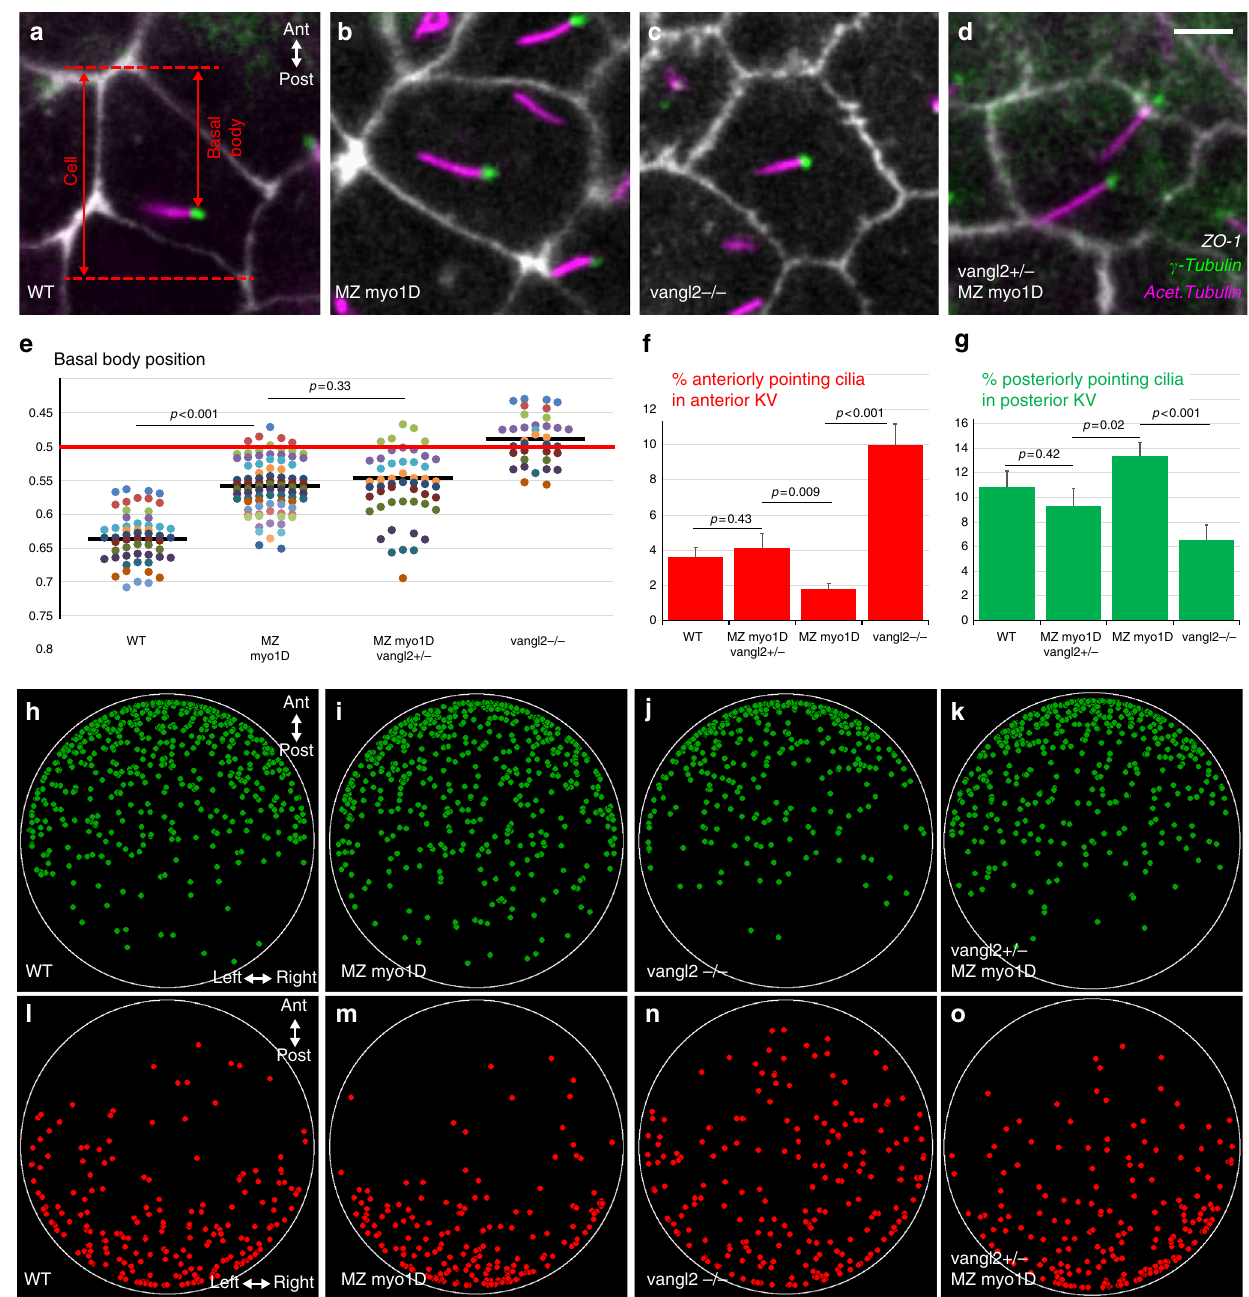
Fig. 6 myo1D interacts with vangl2 to control cilia orientation in the zebra fi sh left – right Organizer. a – e myo1D and vangl2 are required for basal body positioning. a – d High magni fi cation views of KV cells (ZO-1) with cilia (acetylated tubulin) and basal bodies ( γ -tubulin). e Dot plot representing average antero-posterior basal body position in individual embryos (see Methods). Compared to WT ( a , n = 40 embryos/744 basal bodies), basal bodies are displaced anteriorly in MZ myo1D ( b , n = 74/1521) or vangl2 ( c , n = 36/526) mutants. Basal bodies are similarly affected in MZ myo1D and MZ myo1D ; vangl2 + / − ( d , n = 37/826). f , g MZ myo1D ( n = 93 embryos/3172 cilia) and vangl2 ( n = 50/1545) mutations have opposing effects on cilia orientation. Cilia orientation in MZ myo1D ; vangl2 + / − ( n = 35/1225) is similar to WT ( n = 55/2275). h – o two-dimensional dot plots indicating the position of KV cilia pointing to the anterior (red) or posterior (green) in the KV of embryos of different genotypes. Posteriorly pointing cilia invade the posterior KV in MZ myo1D ( i ), while anterior pointing cilia invaded the anterior KV in vangl2 − / − ( n ). In MZ myo1D ; vangl2 + / − ( k , o ), cilia distribution is again more similar to WT (see Supplementary Fig. 9 for details). All data collected at eight-somites stage, anterior up in a – d , h – o . Horizontal bars in e represent mean values. Error bars in f , g indicate SEM. Scale bar: 5 µ m in a – by the Zebra fi sh Mutation Project (http://www.sanger.ac.uk/resources/zebra fi sh/ direct sequencing of the same PCR amplicon that was used in the T7 endonuclease zmp/) and obtained through the Zebra fi sh International Resource Center. The assay. sa17276 point mutation causes the appearance of a premature stop codon in place To genetically invalidate zebra fi sh myo1G (Ensembl gene of amino acid 460, deleting therefore the entire C-terminal half of the protein ENSDARG00000036104), we used two complementary experimental strategies. A including the actin- and cargo-binding domains. fi rst mutant allele ( myo1G sa17276 ) was generated using a TILLING-based approach